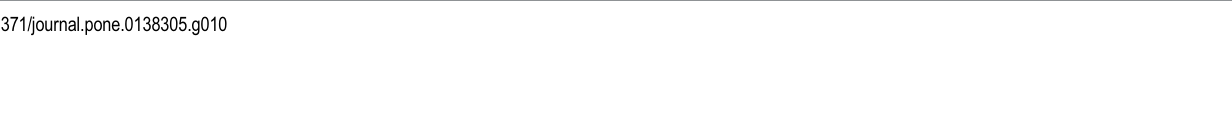
PLOS ONE | DOI:10.1371/journal.pone.0138305 September 14,